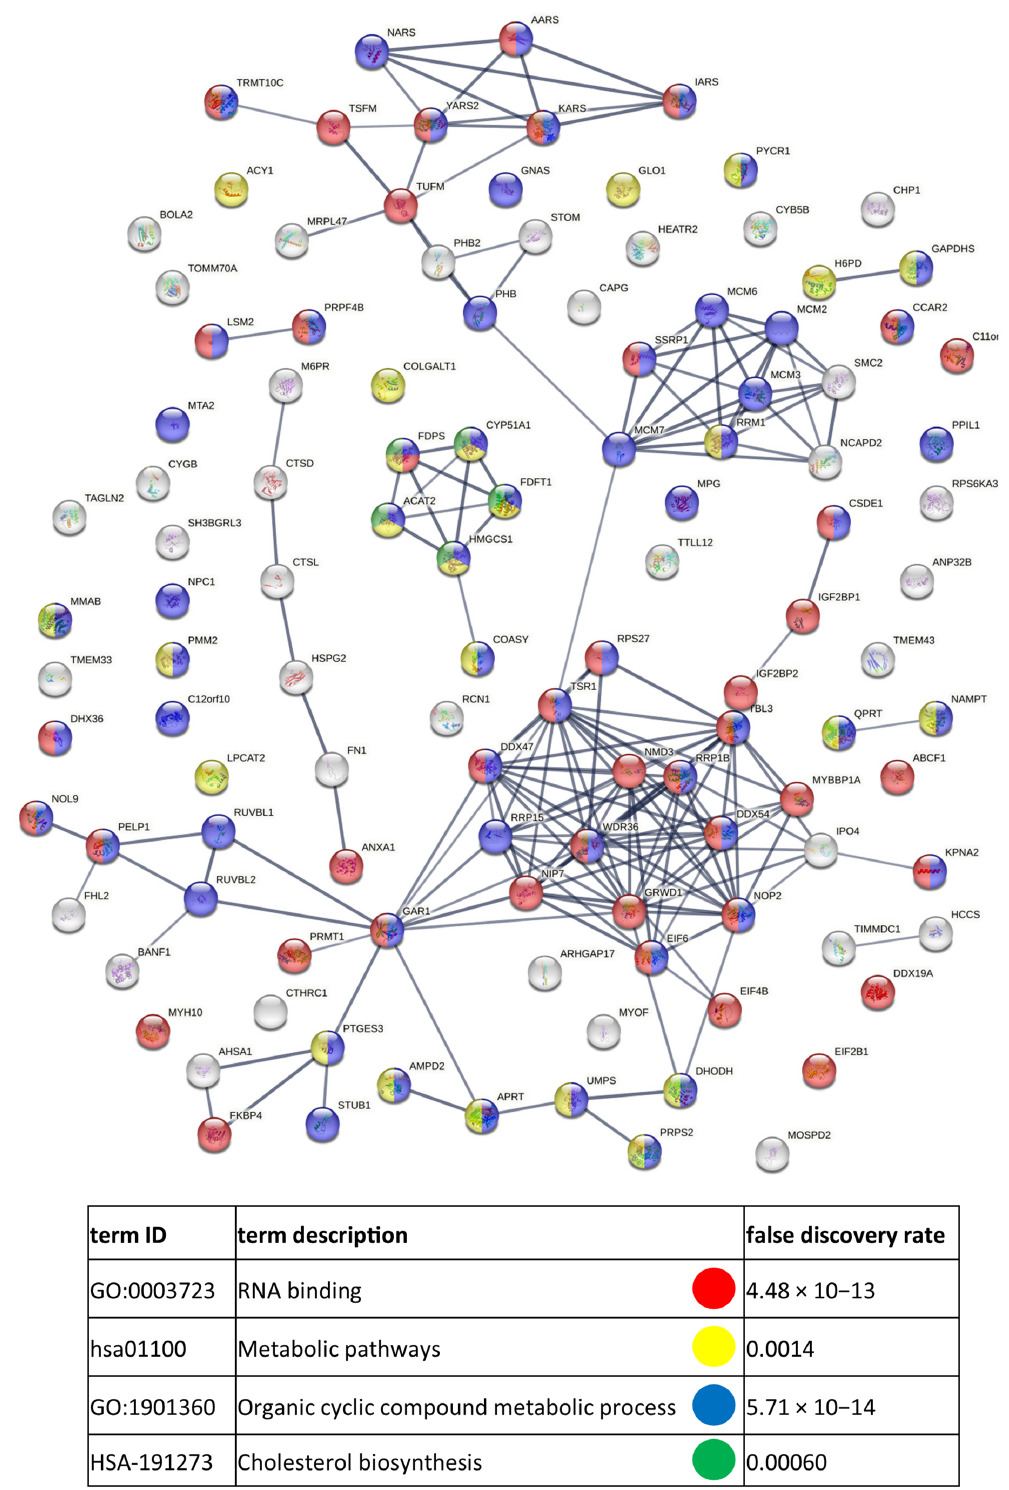
Figure A10. Diagram of functional protein association networks prepared with the use of STRING v. 11.0 software for proteins upregulated in WM115 cells vs. WM266-4 cells. The selected, strongly